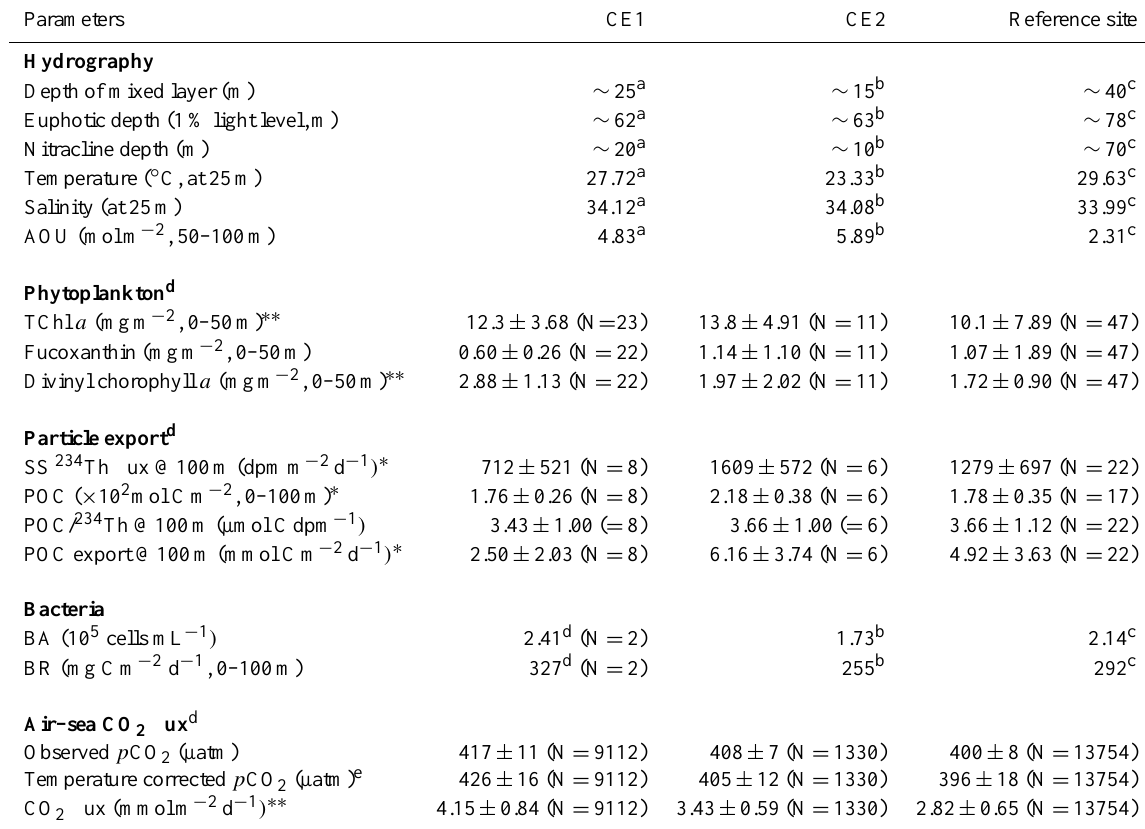
Table 1. Hydrographic characteristics, phytoplankton, particle export parameters, bacterial abundance and respiration and air–sea CO 2 flux in CE1, CE2 and surrounding waters. CE1: cyclonic eddy #1; CE2: cyclonic eddy #2. TChl a : total chlorophyll a ; SS: stable state; POC: particle organic carbon; BA: bacterial abundance; BR: bacterial respiration rate. Non-parametric Kruskal–Wallis test was used for comparison of variables between